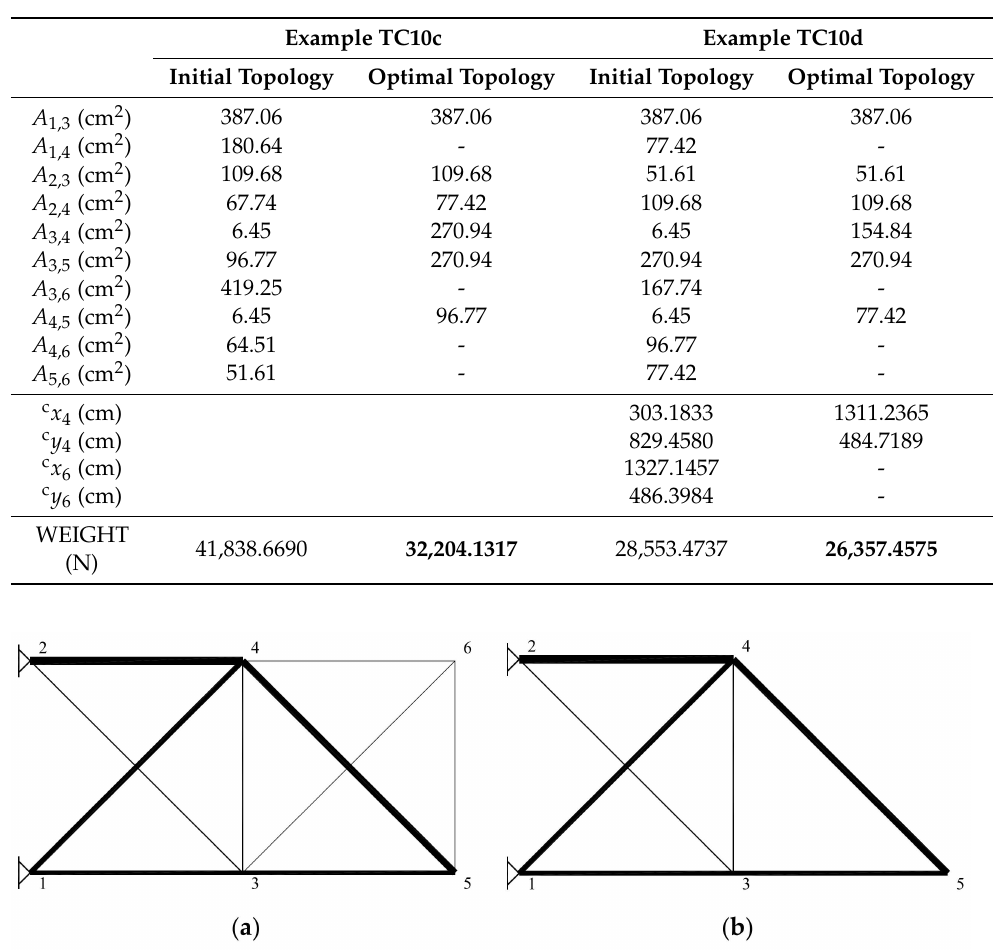
Table 7. Optimal results, examples with buckling constraints TC10c (topology optimization) and